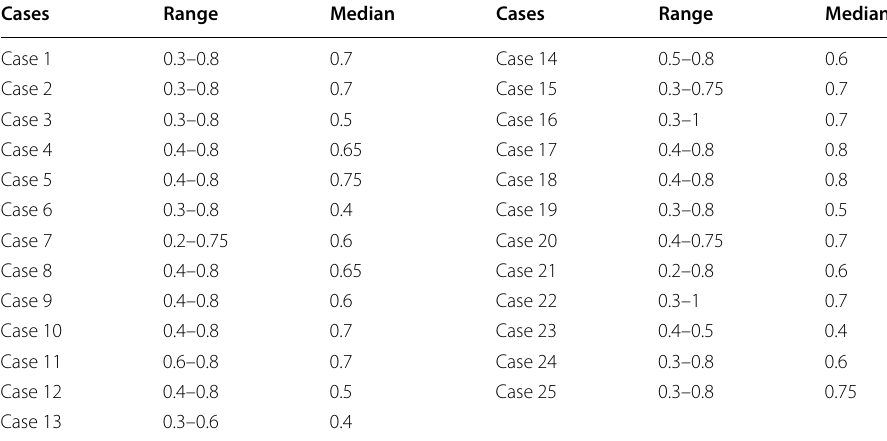
Table 7 Panel estimates for the probabilities to renew for 25 cases